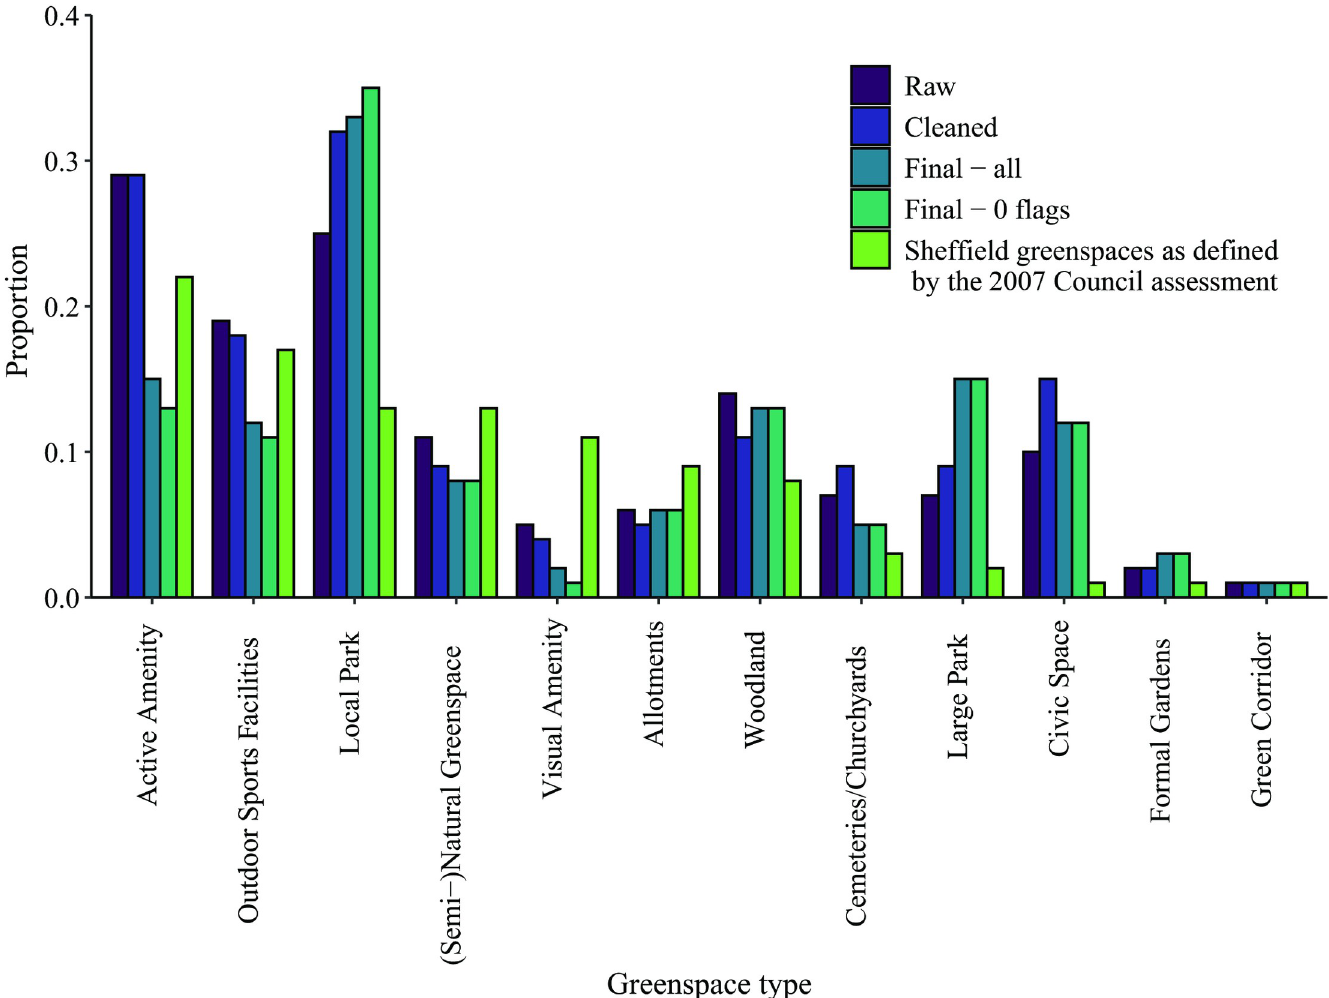
Fig 5. Destinations of trips by greenspace type, at various stages of processing. NB proportions sum more than 1 due to trips visiting multiple greenspaces.